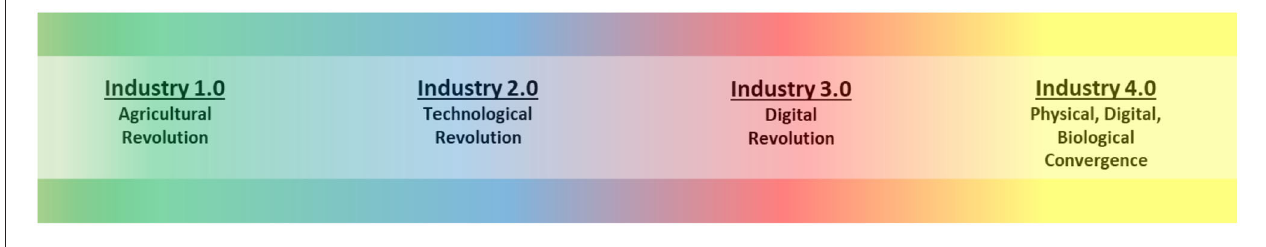
FIGURE 1 | Industrial innovation as a spectrum with no fixed points between